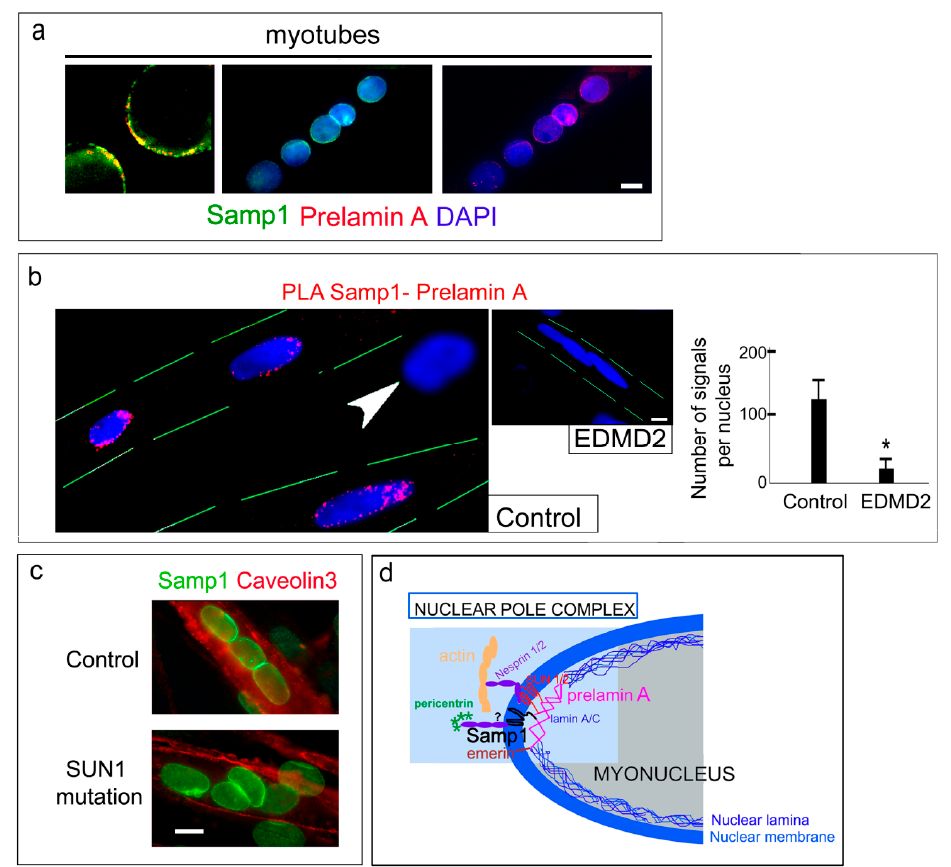
Figure 3. Samp1 co-localizes with farnesylated prelamin A at the nuclear poles of human myotubes. ( a ) Co-staining of Samp1 and prelamin A in human control myotubes (myotubes). Left panel, high magnification of a double stained nuclear pole showing protein colocalization. Single fluorescence of Samp1 and prelamin A are shown along with DAPI staining of nuclei. ( b ) PLA of prelamin A and Samp1 (PLA Prelamin A-Samp1, red dots) in control myotubes. The arrowhead indicates a mononucleated myoblast that is negative for PLA. An EDMD2 myotube negative for PLA is shown in the inset. Graphs show quantitative analysis of PLA signals reporting the average number of spots in nuclei (80 nuclei per sample were counted). ( c ) Immunostaining of Samp1 and Caveolin 3 in control myotubes (control) and myotubes from a muscular dystrophy caused by SUN1 mutation (SUN1 mutation, see methods for details) [17]. ( d ) Schematic representation of the proposed protein platform (myo-Nuclear Pole Complex) at the nuclear envelope of differentiated human myoblasts. Prelamin A interacts with Samp1, SUN1/2, and emerin. SUN1/2 link the complex to nesprins and the actin cytoskeleton. The hypothesis (indicated by “?”) that Samp1 binds nesprin 2G and pericentrin warrants future investigation. Statistically significant differences by the Mann Whitney test are indicated by asterisks (*). Nuclei are counterstained with DAPI (blue). Scale of bars, 10 µm.